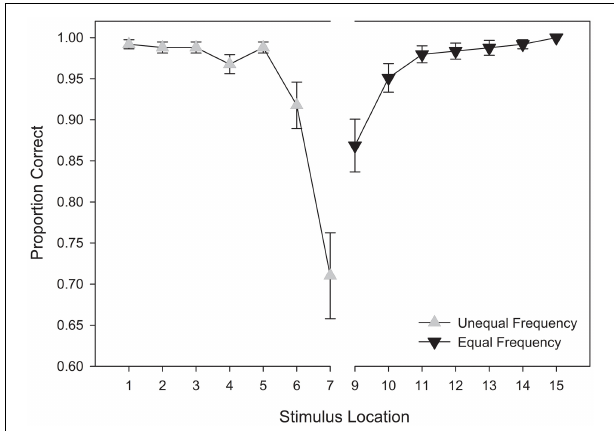
FIGURE 13 | Test categorization response time in the unequal frequency, unequal distribution condition. Stimulus values correspond to stimuli selected from the entire stimulus range (i.e., stimuli 1–15). Error bars represent 1 standard error of the mean ( N = 60).